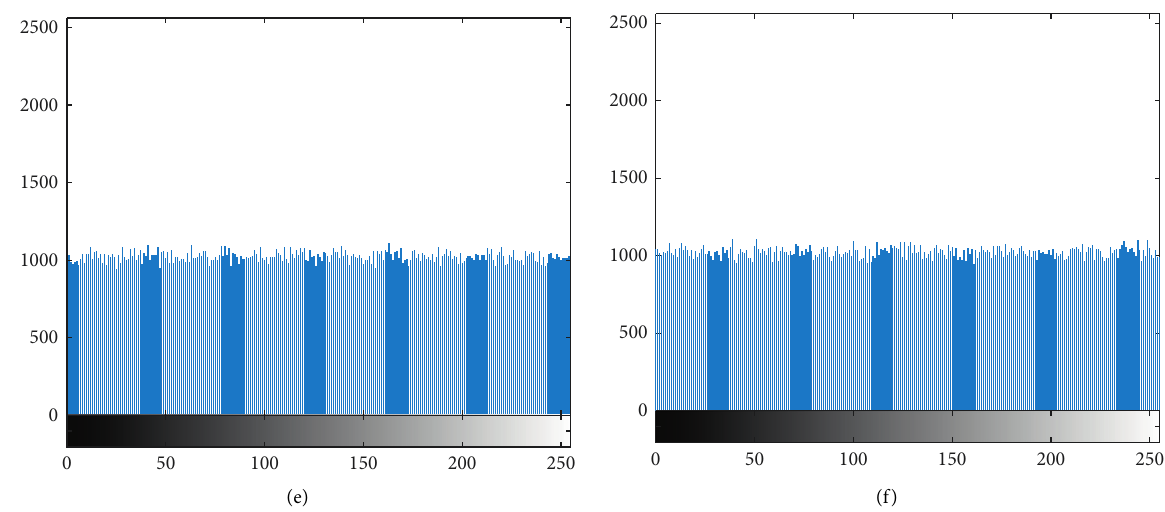
Figure 10: Histogram of every component of RGB (Lena); (a) histogram of R of plaintext; (b) histogram of G of plaintext; (c) histogram of B of plaintext; (d) histogram of R of ciphertext; (e) histogram of G of ciphertext; (f) histogram of B of ciphertext. Table 3: Values of χ 2 for plain and encrypted Lena images. χ